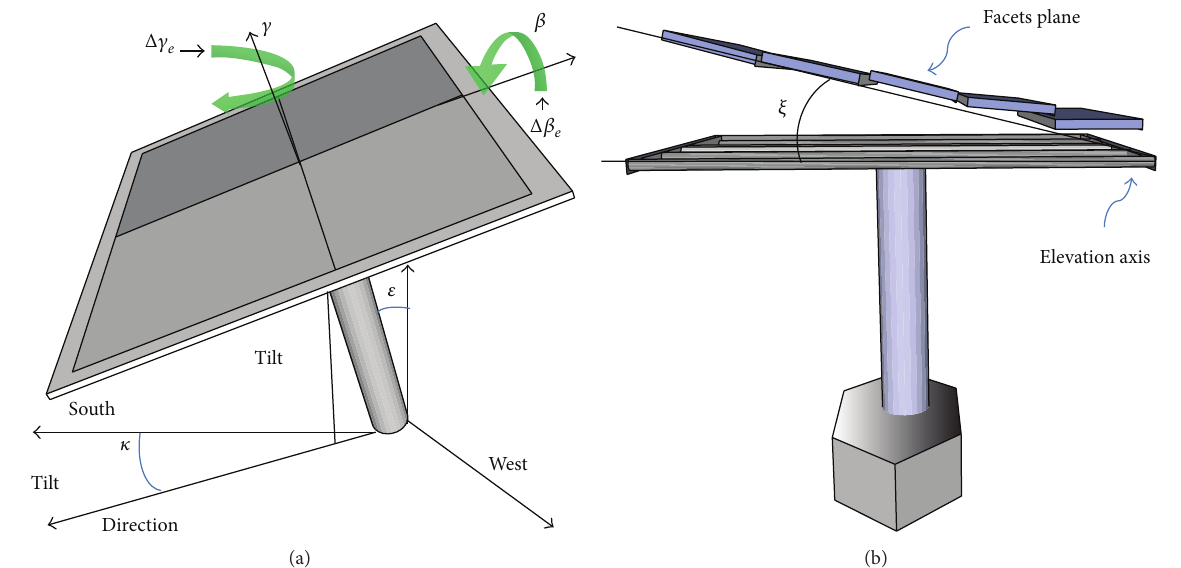
Figure 2: Primary error sources: angular reference offset and inclination of the azimuth rotation plane due to pedestal or gearbox tilt (a); canting error (b).